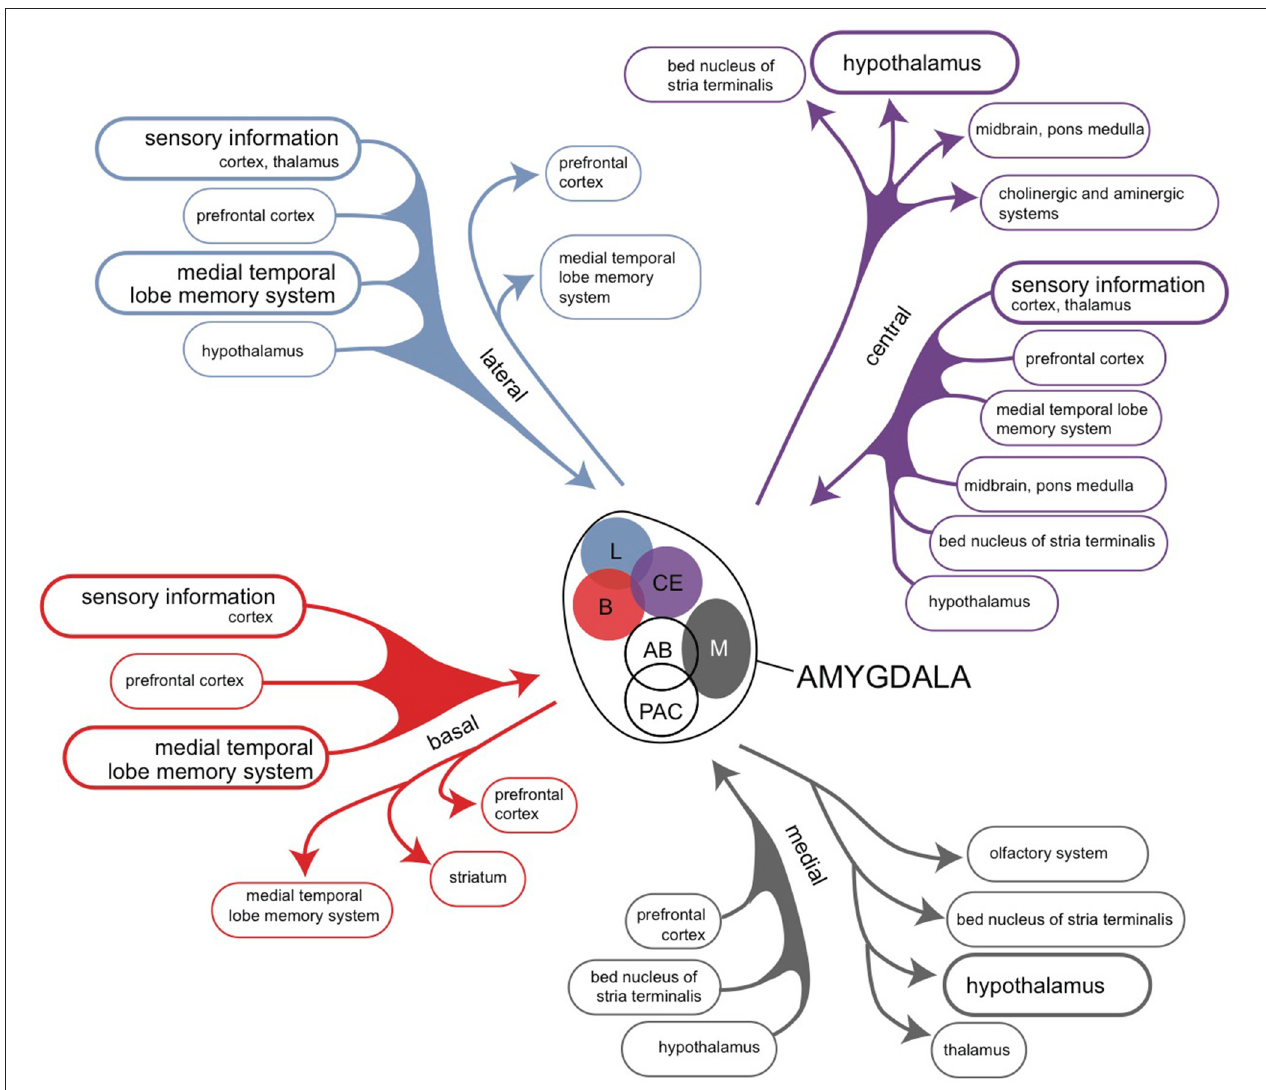
FIGURE 7 | Overview of the connectivity of the rat amygdaloid complex (Pitkänen,